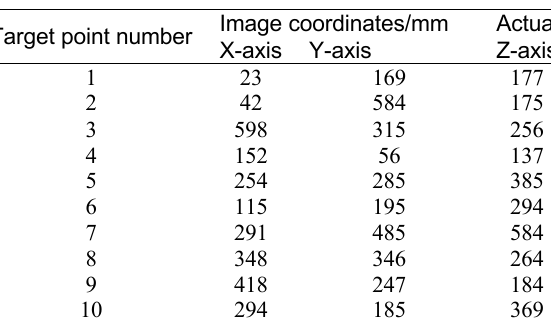
Table 1. Comparison of actual coordinates and